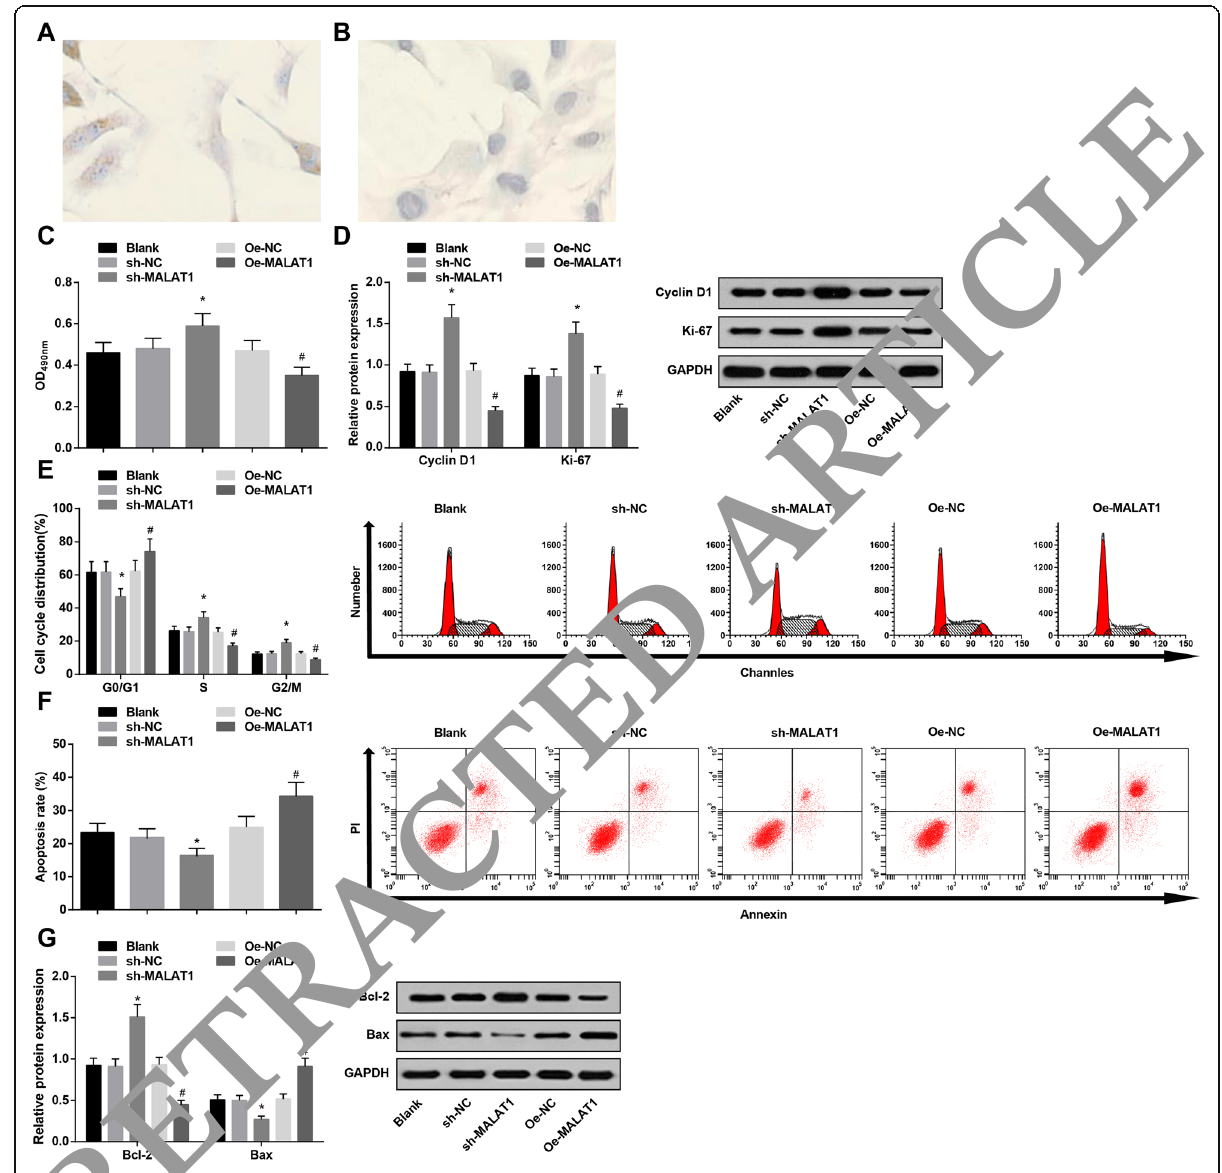
Fig. 3 Low expression of MALAT1 advances viability and restrains apoptosis of vascular endothelial cells in IA. a vWF immunohistochemical staining in IA vascular endothelial cells: IA vascular endothelial cells were covered with fine yellow particles. b vWF immunohistochemical staining in IA vascular endothelial cells: IA vascular endothelial cells showed no brown particles in the NC group. c Vascular endothelial cell viability in each group by MTT assay. d Protein expression of CyclinD1 and Ki-67 in each group by western blot analysis. e Cell cycle changes in each group by PI staining. f Cell apoptosis rate in each group by Annexin V/PI double staining. g Bax and Bcl-2 protein expression in each group by western blot analysis. * P < 0.05 vs. the sh-NC group, # P < 0.05 vs. the Oe-NC group. Measurement data were depicted as mean ± standard deviation, and comparisons among multiple groups were assessed by one-way analysis of variance followed with Tukey ’ s multiple comparisons